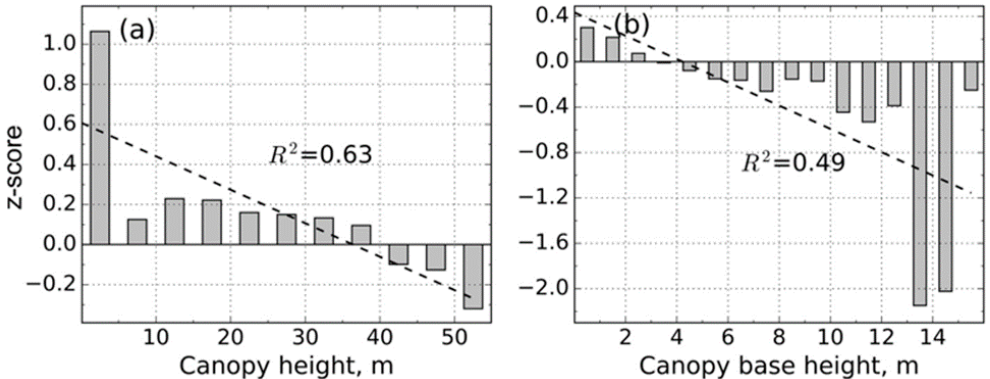
Figure 6. Relationship between z -score (significant differences) in modeled CBP between Model 1 and Model 2 (Canopy Height + Error) and ( a ) canopy height, and ( b ) canopy base height.